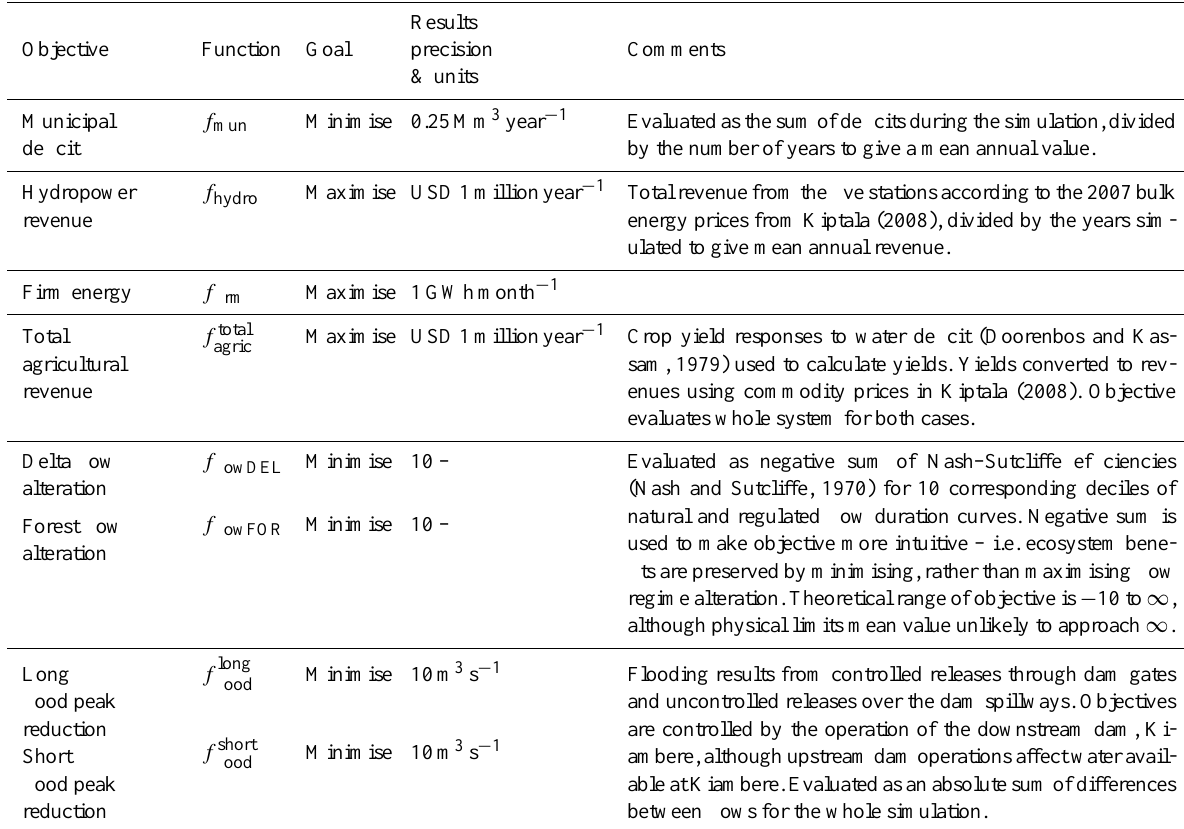
Table B1. Objective function goals, results precision, units and comments.